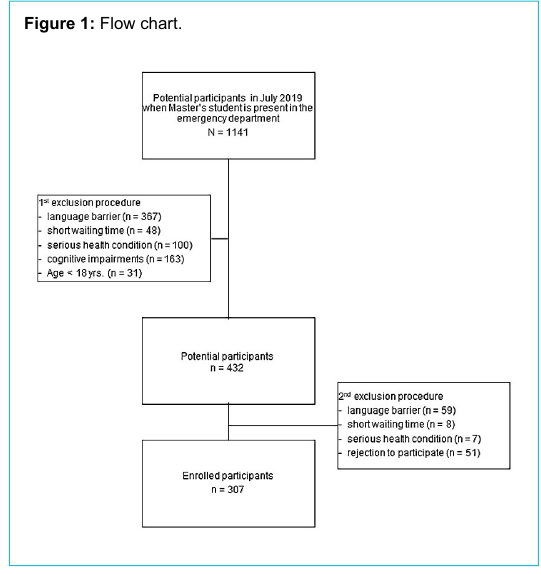
Table 5: Factors associated with a higher likelihood of having an organ card or being registered in the National Organ Donor Registry Neither organ donor card hold- er nor registered, n = 245 (79.8%)